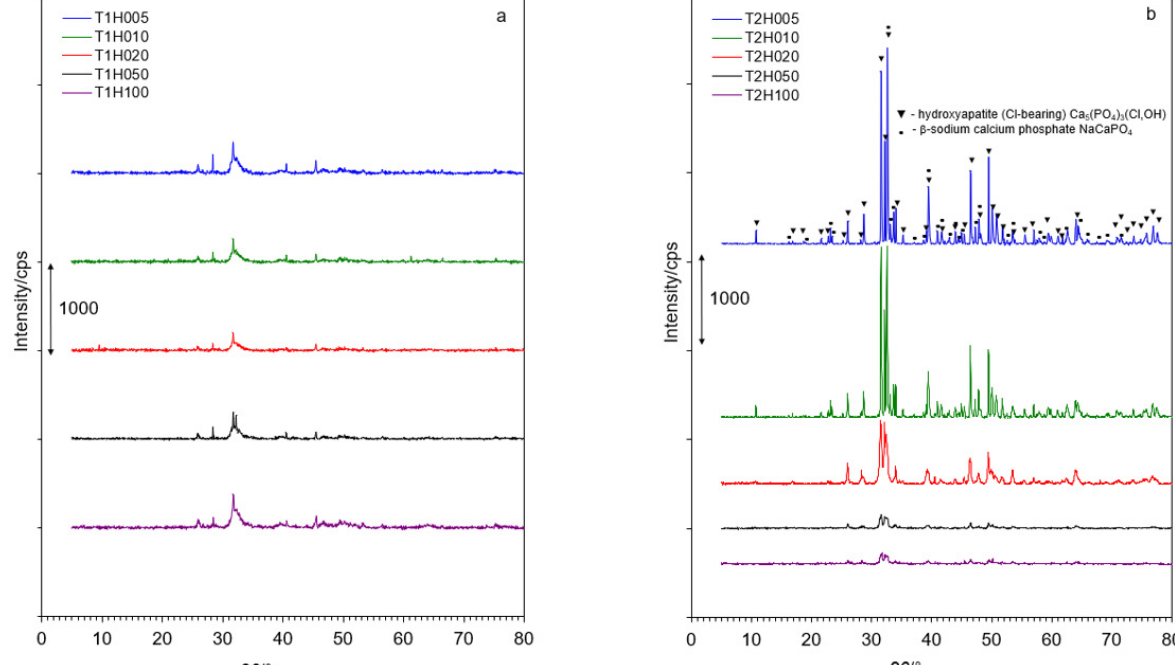
Figure 5. FTIR spectra of untreated MBM sam- Figure 7. XRD pattern of residues after pyrolytic MBM decomposition up to 600 °C (left) and 1000 °C (right) for different heating ple and commercially available hydroxyapatite.